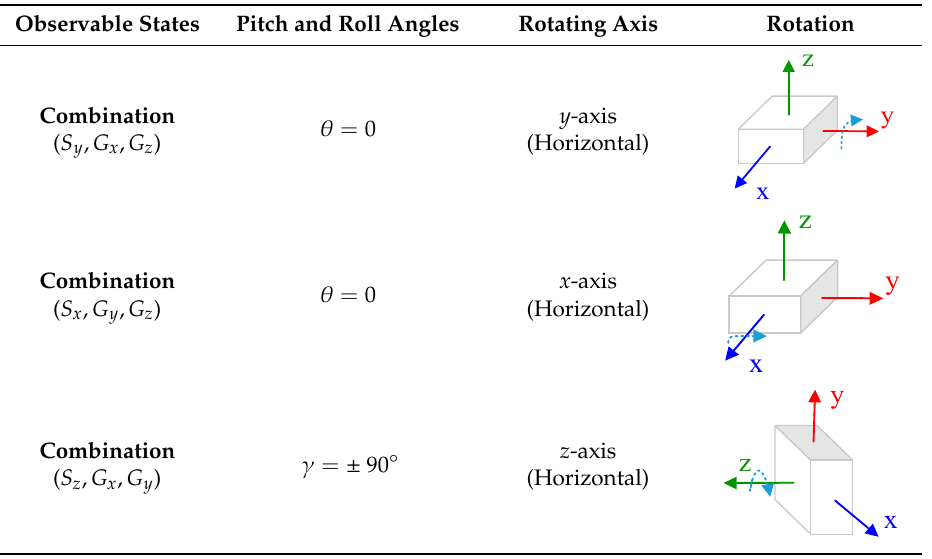
error Velocity Random Walk (VRW) are simulated according to the consumer level MEMS sensor performance and listed in Table 7. These error parameters are substituted into the sensor measurement model to generate the output and are used for